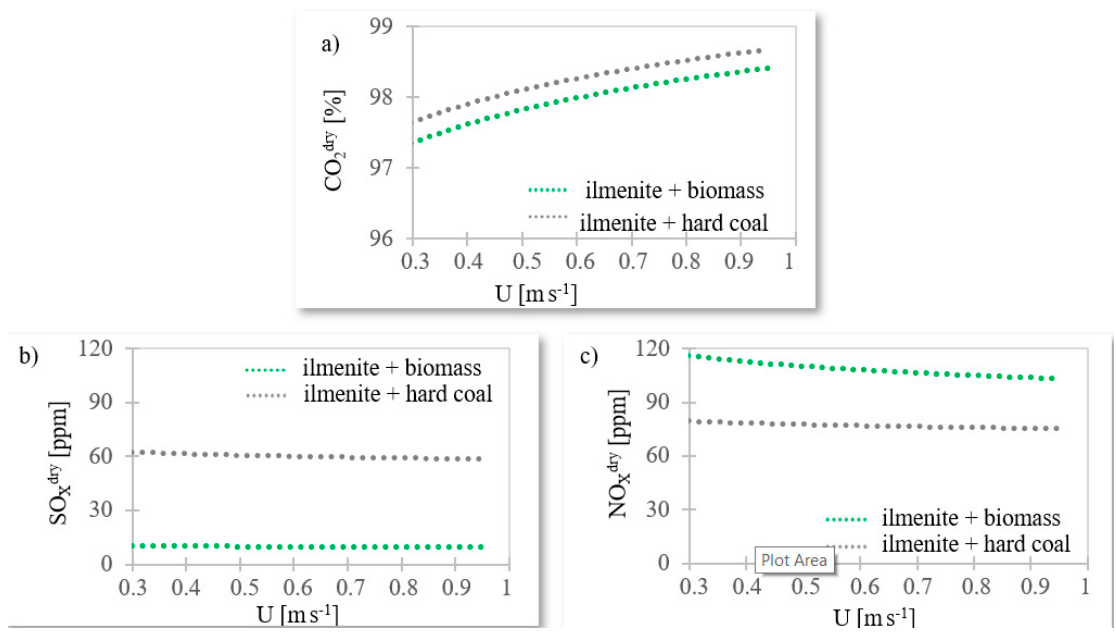
Figure 18. The emissions from hard coal and biomass combustion versus the superficial gas velocity in the FR: ( a ) CO 2 , ( b ) SO X , ( c ) NO X .